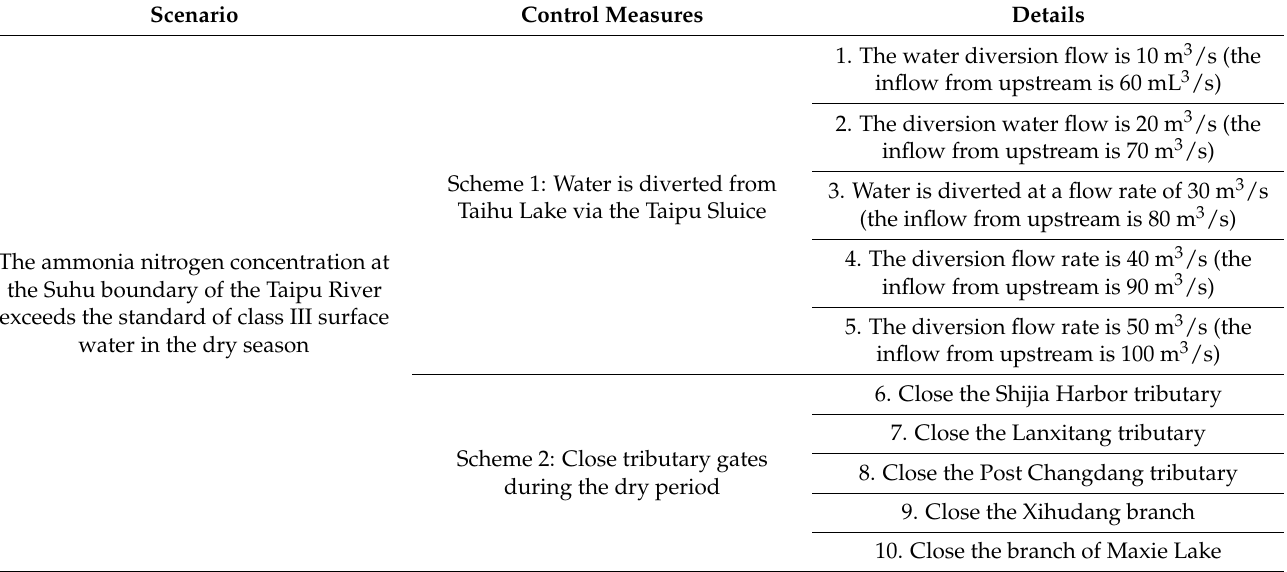
Table 8. Risk reduction and emergency response for scenario 1.